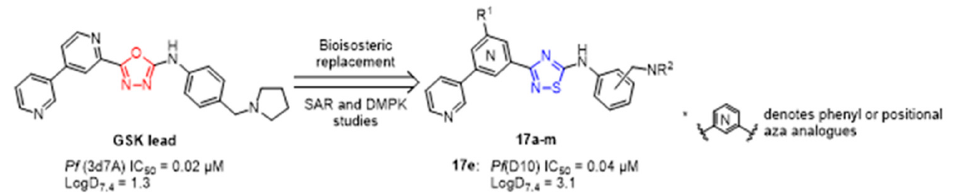
Figure 24. Synthesis of aminothiadiazole analogues 17a-m.